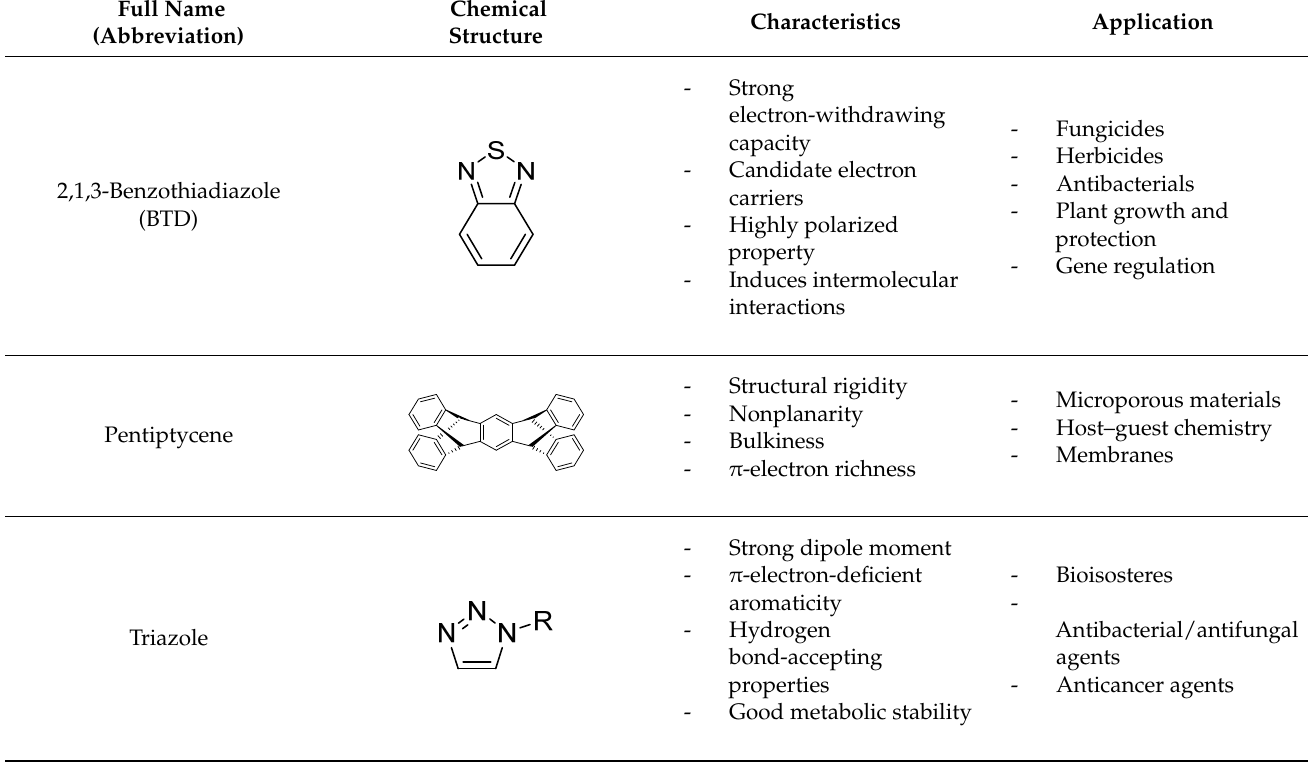
Table 4. Summary of the chemical units of polymer-based photoluminescence probes a .